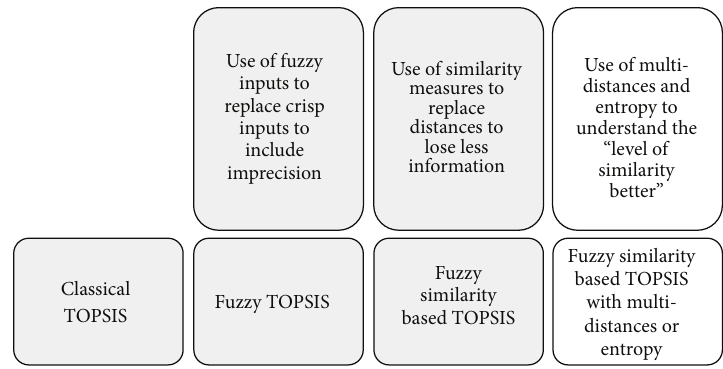
Figure 1: Evolution of TOPSIS variants with the contribution area of this research on light